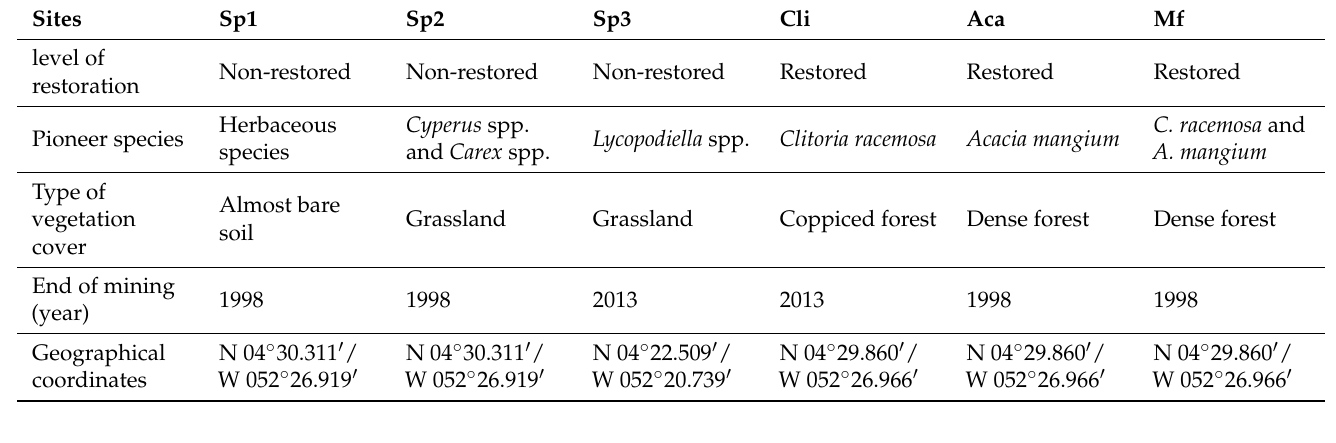
Table 6. Main characteristics of the 6 sampled sites.